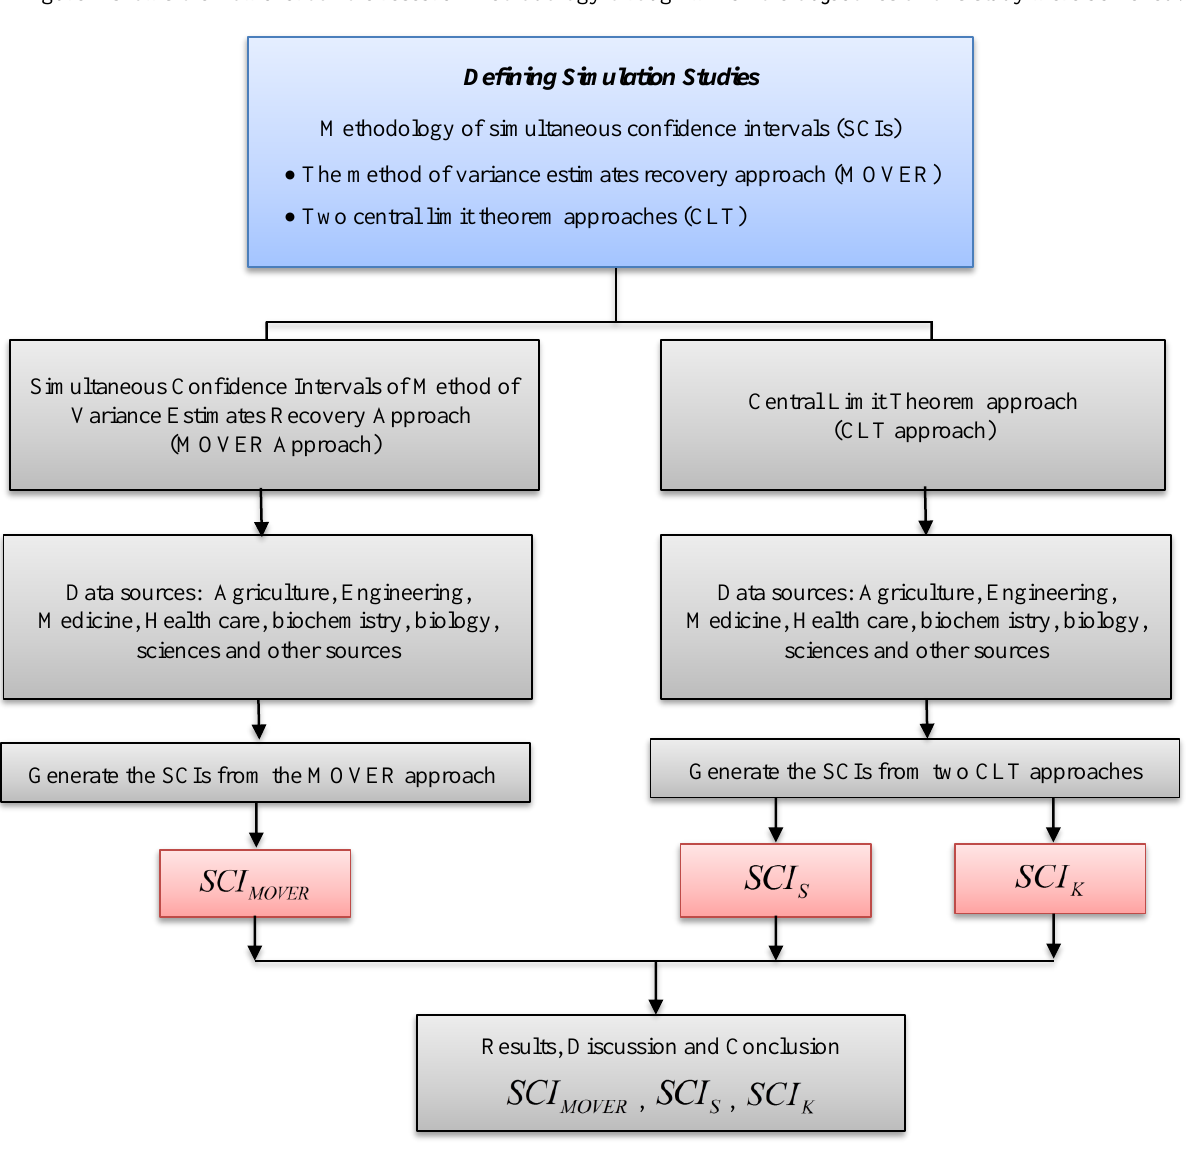
Figure 1. Flowchart of the research